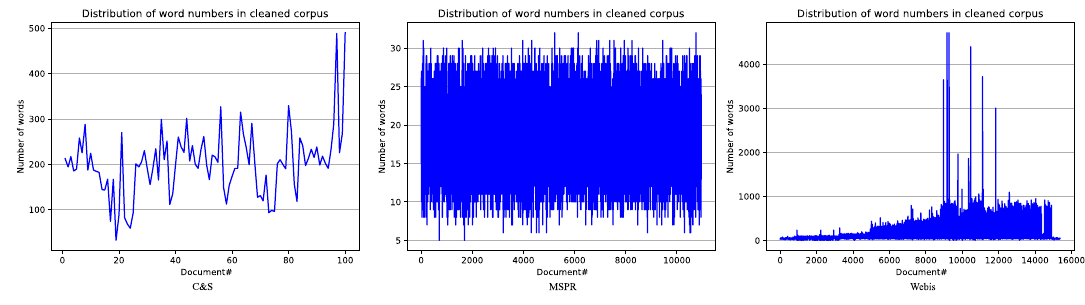
Figure 3. Document word number distributions in corpus files.